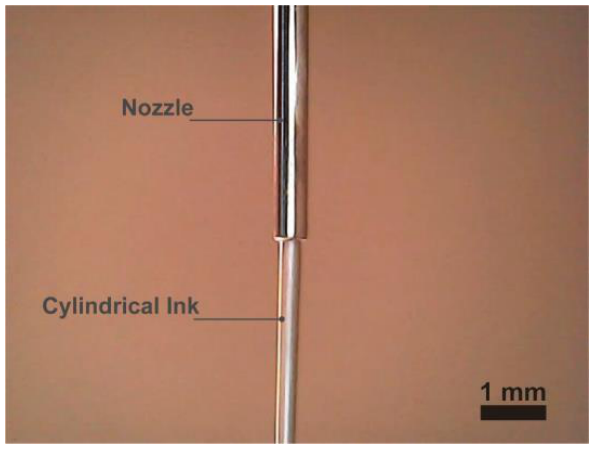
Figure 1. Schematic diagram of cylindrical ink extrusion from a nozzle. Measurement of ink surface flatness: A white light interferometer (FMD-D) was used to obtain surface information of the ink layers. The surface profile data of the ink surface were obtained and processed using software